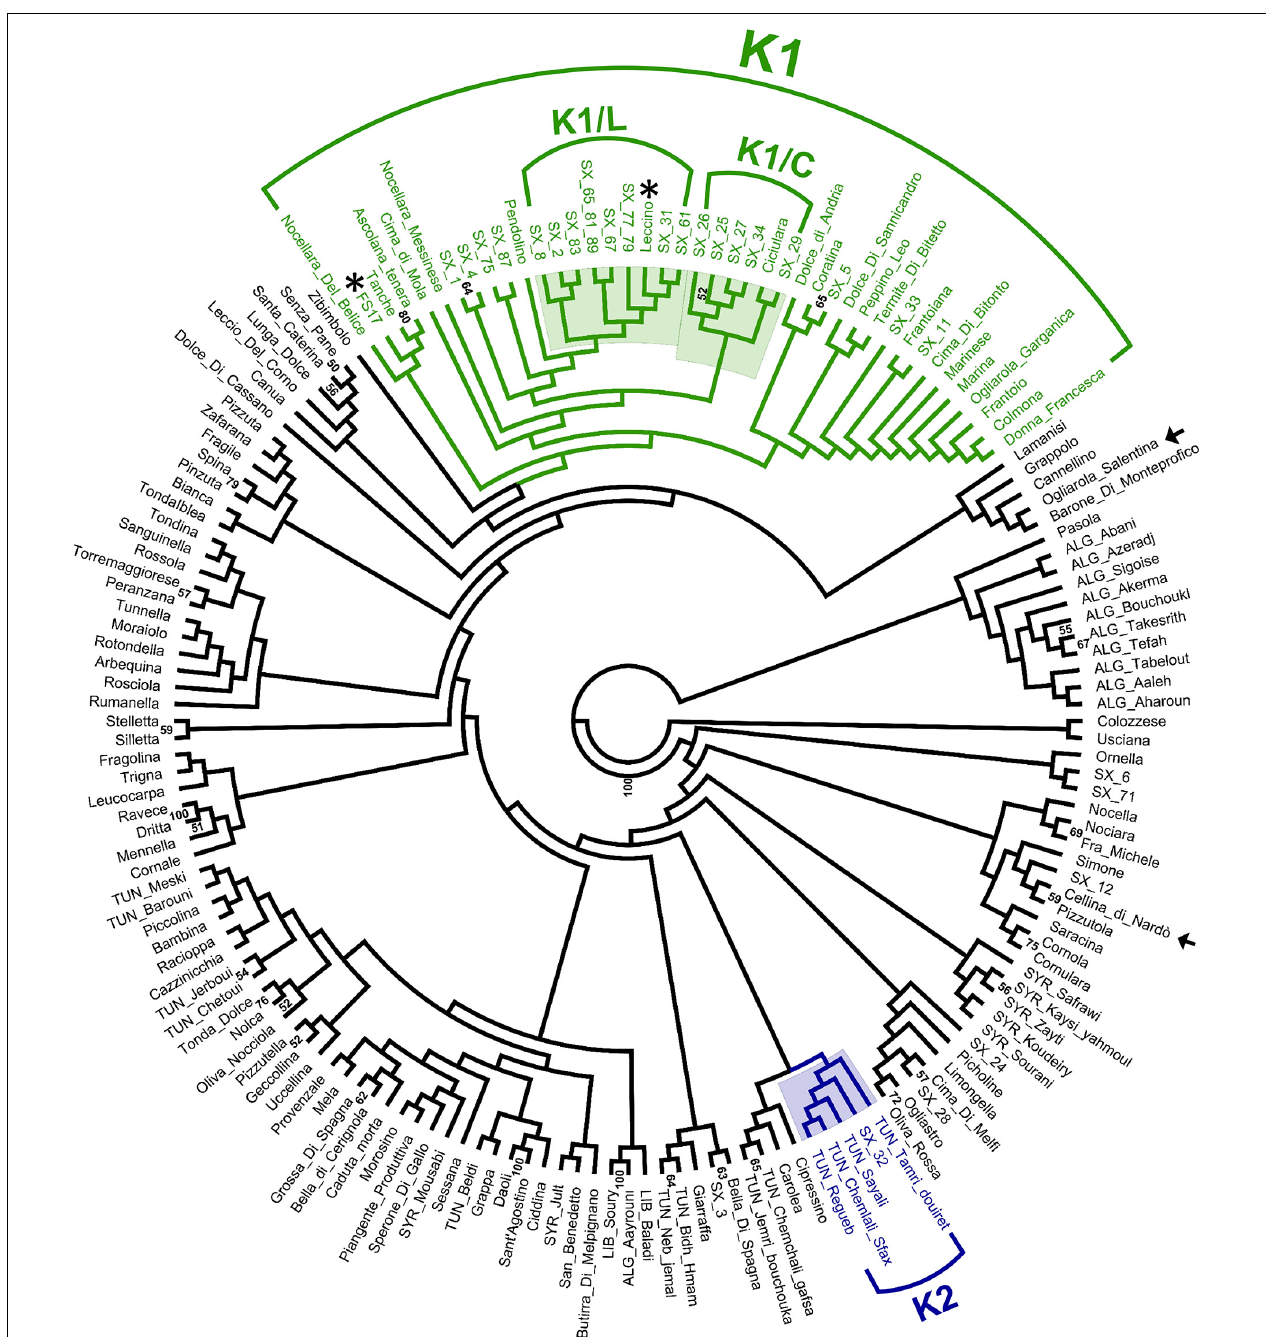
FIGURE 3 | UPGMA clustering based on short sequence repeat (SSR) DNA fingerprints of 30 putatively resistant plants and 141 olive cultivars. The cluster K1 (with the sub-clusters K1/L and K1/C) and the cluster K2 are highlighted. Bootstrap values > 50 are shown. The resistant and susceptible control cultivars are indicated with asterisks and arrows,